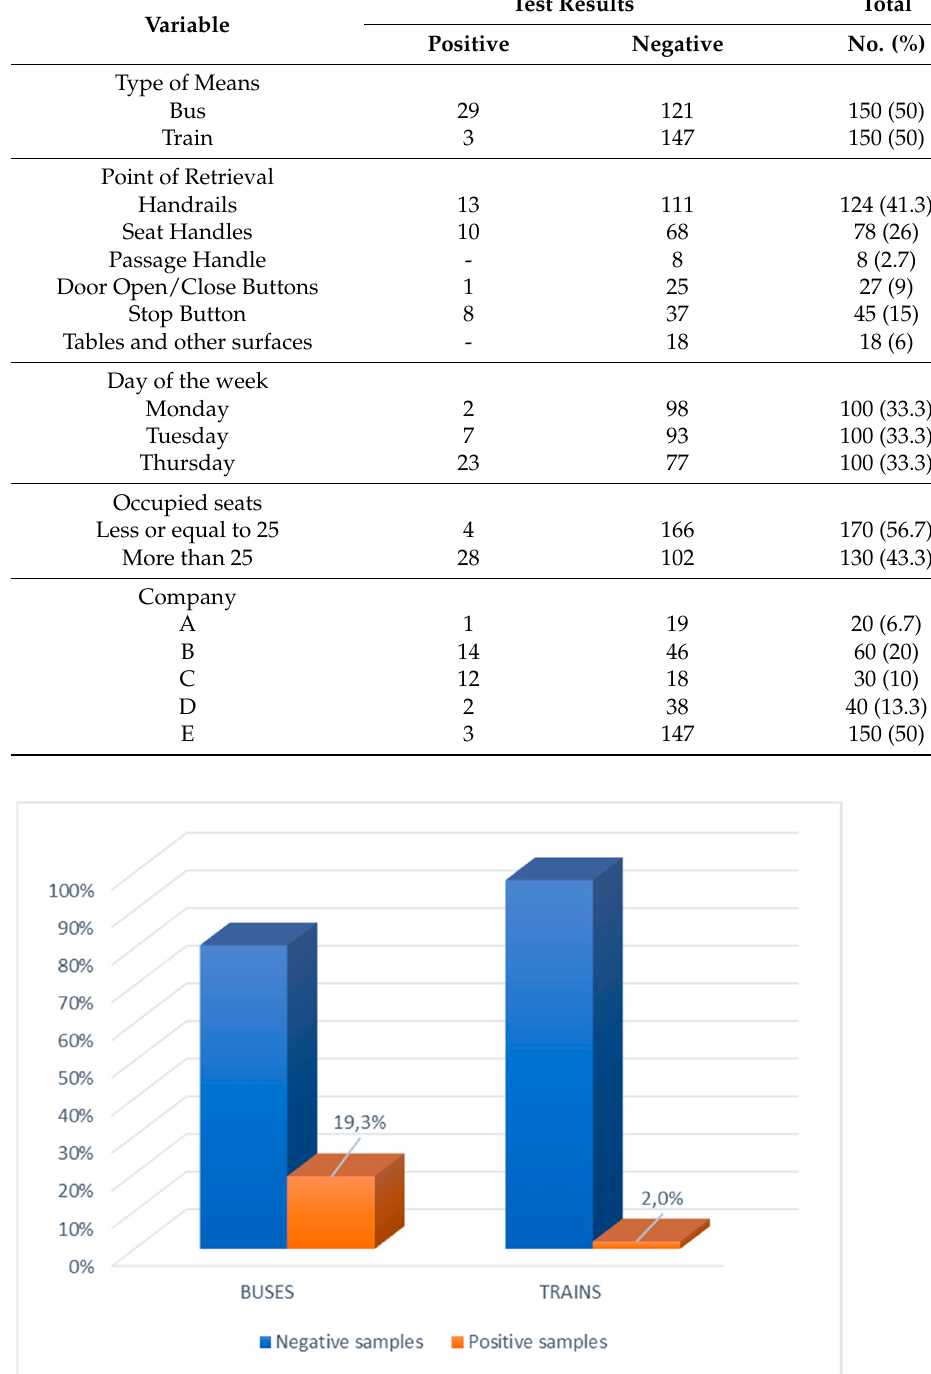
Figure 1. Distribution (%) of positive and negative samples taken from buses and trains. Accordingly, the odds ratio in Table 2 for positive samples on buses was 11.73 (95% CI 3.5–39.5). On buses, the most contaminated surfaces were the handles near the seats (12.8%) followed by door open/close buttons (12.5%) and handrails (10.5%). The odds ratio of positive samples was not statistically significant (Table